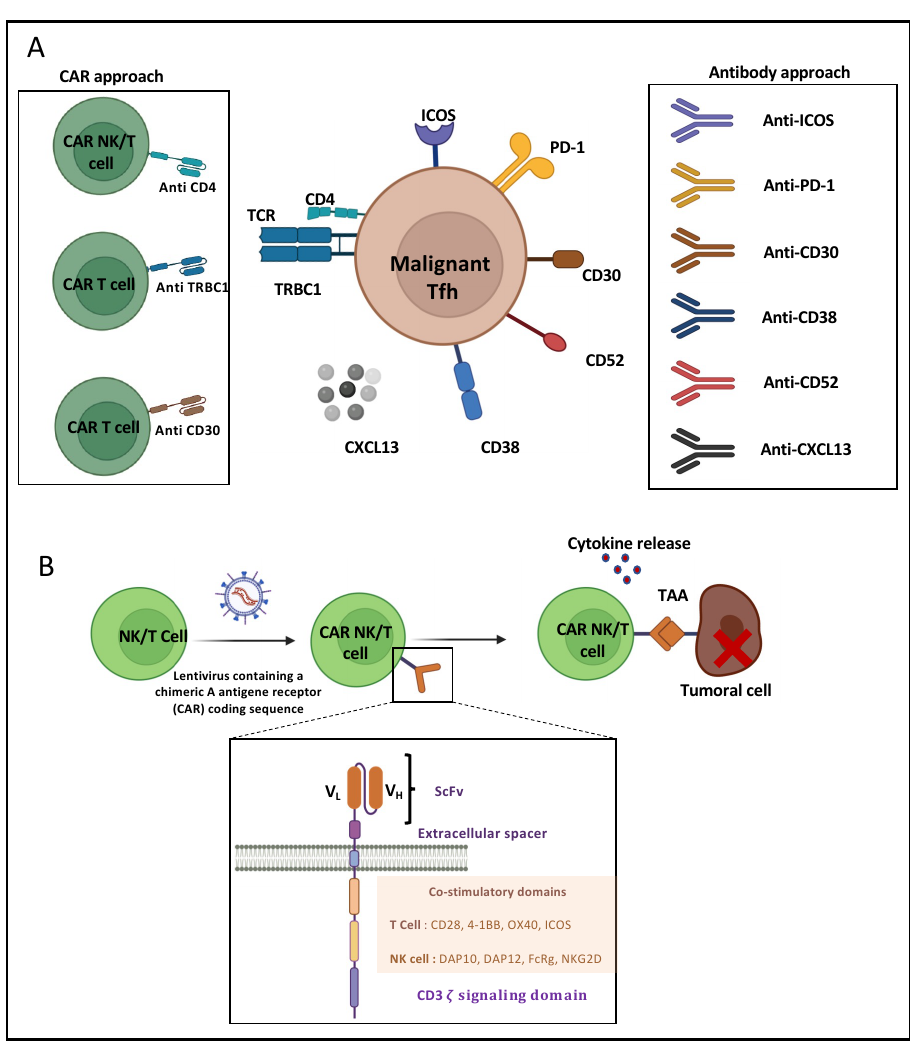
Figure 4. AITL immunotherapy approaches. ( A ) T-cell follicular helper (TFH) cells of AITL express several surface markers targetable by antibodies and CARs: inducible T-cell co-stimulator (ICOS), programed death 1 (PD-1), cluster of differentiation (CD) CD4, CD30, CD38, CD52 and